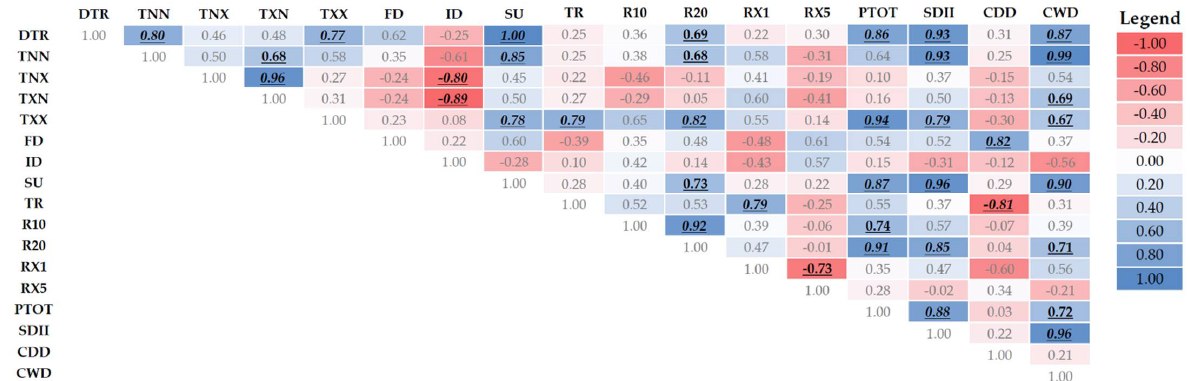
Figure 2. The correlation matrix between the annual trend magnitudes of all 17 extreme climate indices during the period of 1988–2020. (Underlined and bold formatted values are significant at 0.10, and underlined, and bold italicized values are significant at 0.05; RX1, RX5, and PTOT corresponds to RX1DAY, RX5DAY, and PRCPTOT indices, respectively).